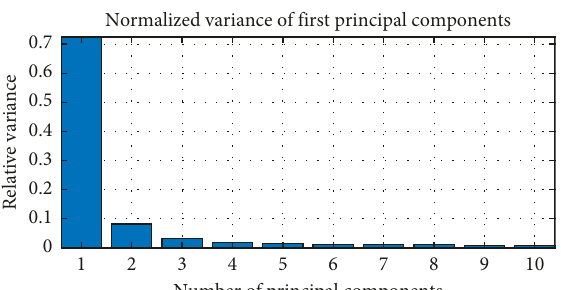
Figure 4: The relative variance of first principal components.